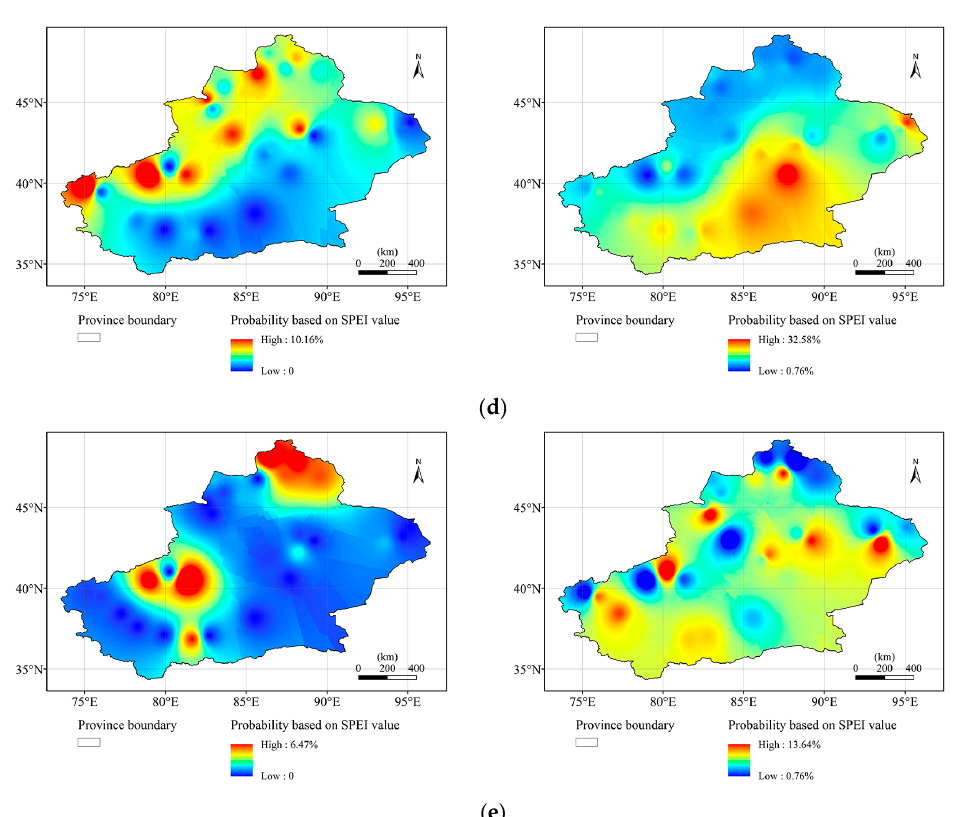
Figure 12. Spatial distribution of occurrence frequency of drought ( a ), mild drought ( b ), moderate drought ( c ), severe drought ( d ), and extreme drought ( e ) during 1960–1996 (left hand side) and 1997–2018 (right hand side).